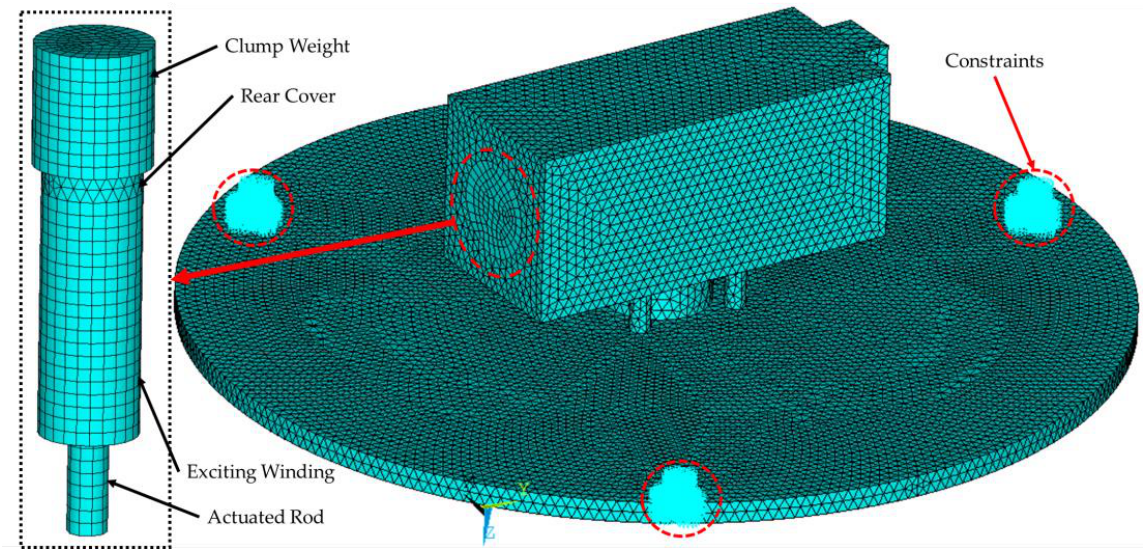
Figure 5. Grid and impose constraints.